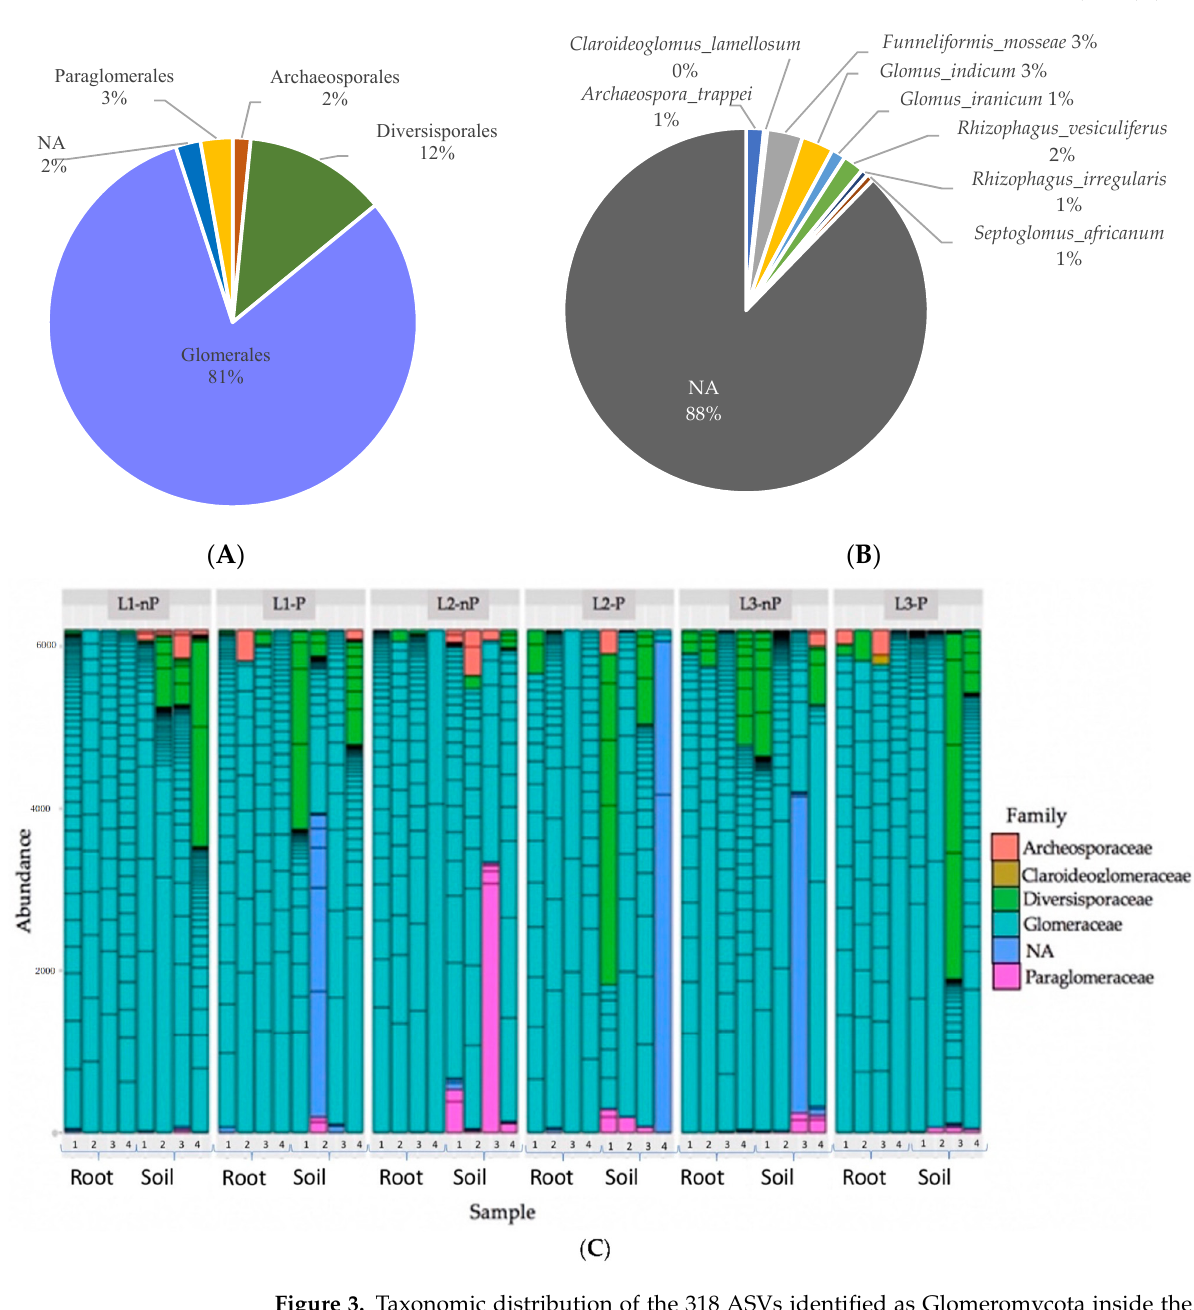
8 of 21 Figure 2. Richness (Chao 1 estimator) and diversity (Shannon and Simpson) indexes comparing AMF communities of ( A ) P versus nP soils, root and soil data being pooled; ( B ) root versus rhizo- spheric soil samples, P and nP site data being pooled. Within each graph, different letters denote significant differences using the Kruskal–Wallis nonparametric test ( p < 0.05). 3.4. Taxonomic Assignment of ASVs The 318 ASVs identified as Glomeromycota were assigned to Glomerales (81%), Di-